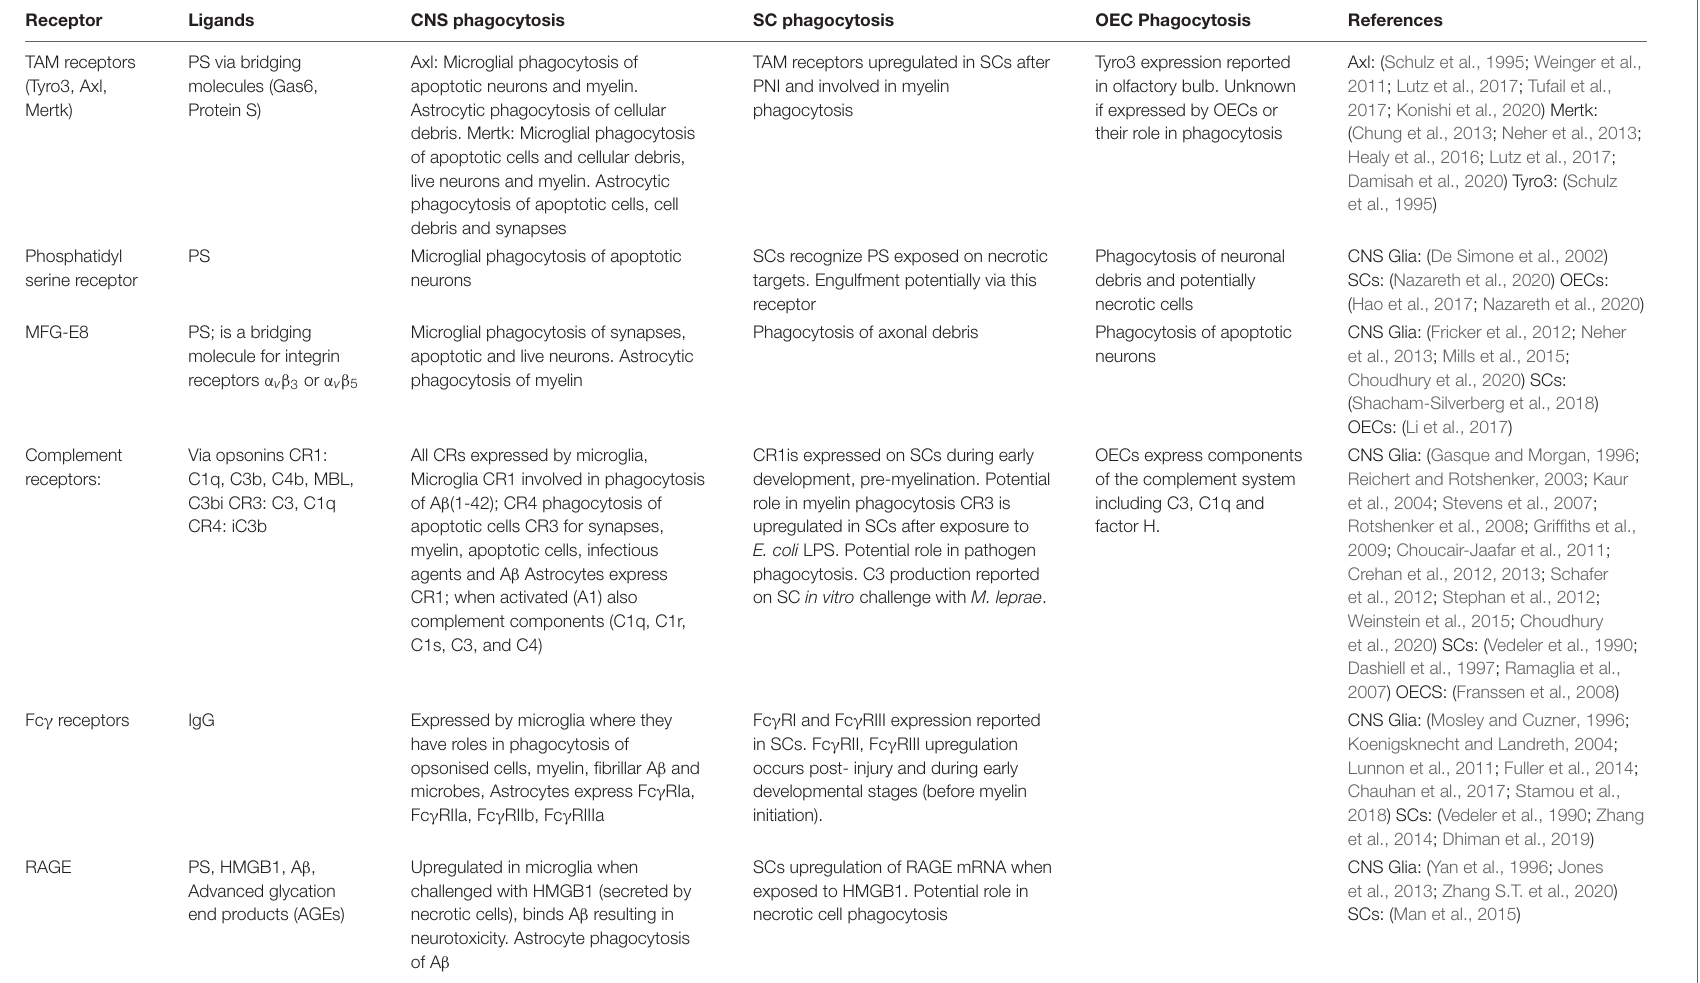
TABLE 1 | Phagocytic receptors and co-receptors involved in glia